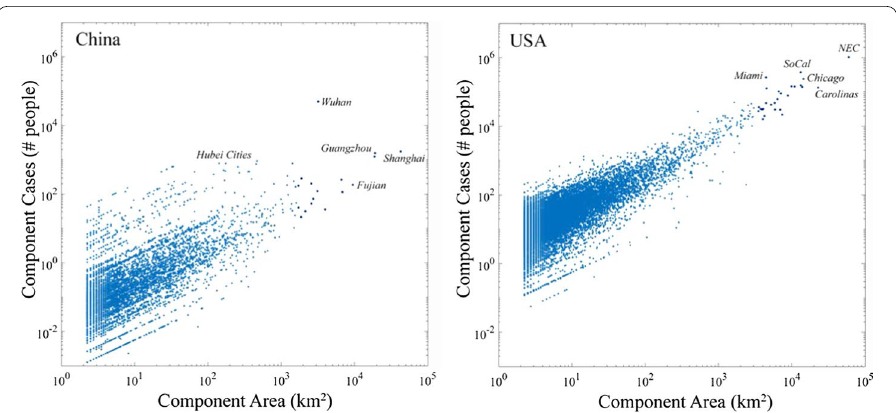
Fig. 10 Component case totals versus component areas for China and the USA. The regional scale gradient in case distribution in China results in a wider range, and generally lower number, of cases relative to component area compared to USA. The wide range of cases in smaller components in the USA is a result of small components within larger counties with different numbers of cases. As components become larger than individual counties, this effect is reduced and a consistent trend emerges. Nonetheless, even for large components, considerable variability persists because of both intra-component case density gradients and because of different temporal trajectories leading to differences in total number of